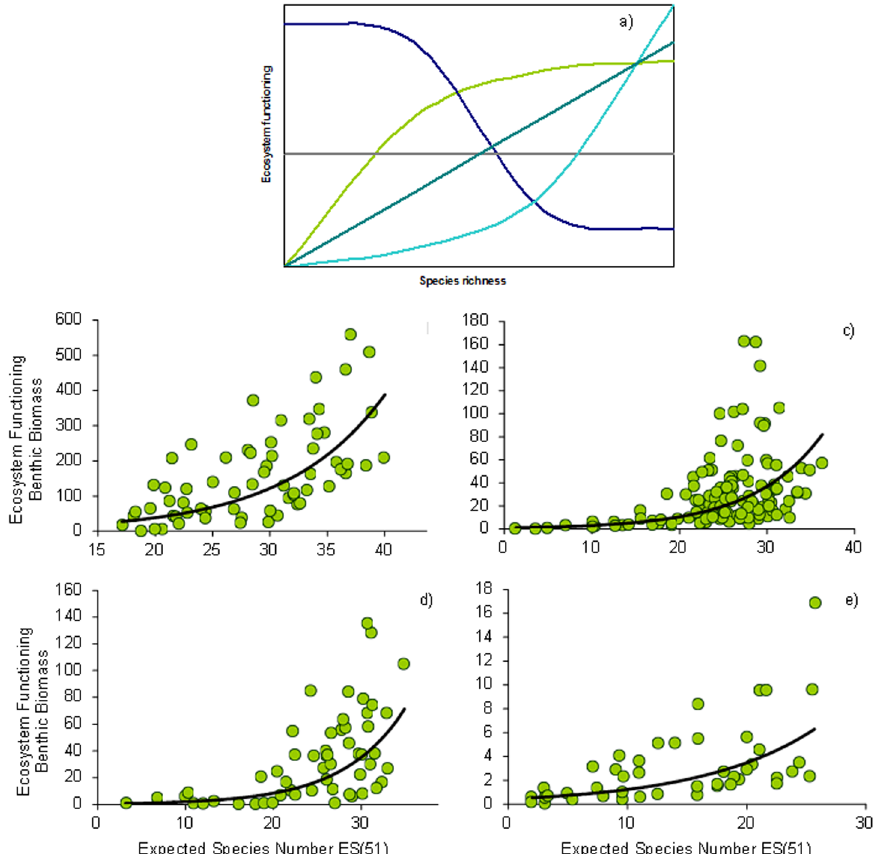
Figure 6. Marine biodiversity, functional diversity and ecosystem functioning. A) Conceptual diagram drawn using data from the North- Eastern Atlantic and Mediterranean Sea (Dark green: positive linear relationship between biodiversity and ecosystem functioning indicating the presence of functional complementarity among species; Light green: saturating relationship between biodiversity and ecosystem functioning indicating functional redundancy; Purple line: non-linear negative relationship between biodiversity and ecosystem functioning indicating a possible effect of selection of the few best performers; Blue line: positive and exponential relationship between biodiversity and ecosystem functioning indicating a positive interspecific interaction, such as facilitation)..([22,43,80]). (B-E) The relationship between expected species number [ES(51)] and ecosystem functioning (as benthic biomass m gC 10 cm -2 ) for nematodes are based on European data from Danovaro et al. [41] with new data from 198 sites from the Atlantic margins and Mediterranean Sea. The equation of the fitting lines are: b) y=3.84e 0.12 6 (n=64, R 2 =0.41, p , 0.01) in the North-east Atlantic; c) y=0.44e 0.10 6 (n=45, R 2 =0.45, p , 0.01) in the Eastern Mediterranean; d) y=0.50e 0.14 6 (n=55, R 2 =0.46, p , 0.01) in the Central Mediterranean and e) y=0.86e 0.13 6 (n=128, R 2 =0.52, p , 0.01) in the Western Mediterranean.